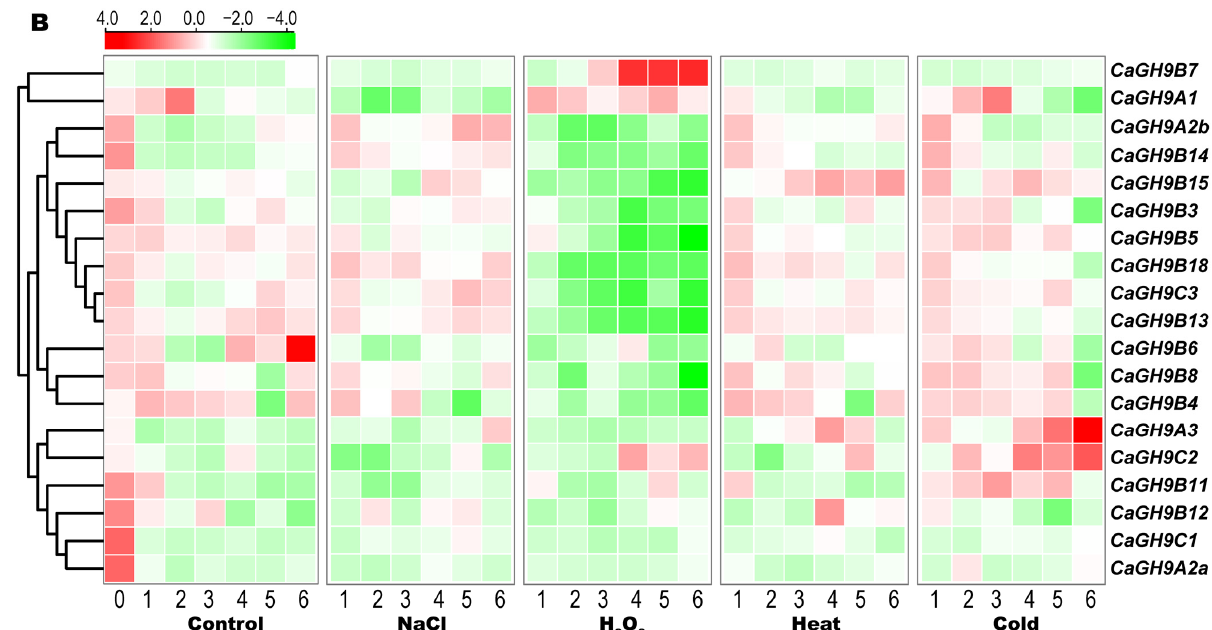
Figure 7. The expression patterns of GH9 family genes under the treatment of phytohormones ( A ) and stresses in pepper leaf ( B ). Log2 and row scale normalization were applied to the RNA ‐ seq based RPKM values, and the heatmap visualization was performed using TBtools. The numbers 0 – 6 represent different time points (0, 1.5, 3, 6, 12, 24 h) before (0) and after treatment. The color scale shows increasing expression level from green to red. SA, salicylic acid; ABA, abscisic acid; GA, gib ‐ berellin; IAA, indole ‐ 3 ‐ acetic acid; JA, jasmonic acid. RNA ‐ seq data were retrieved from Pep ‐